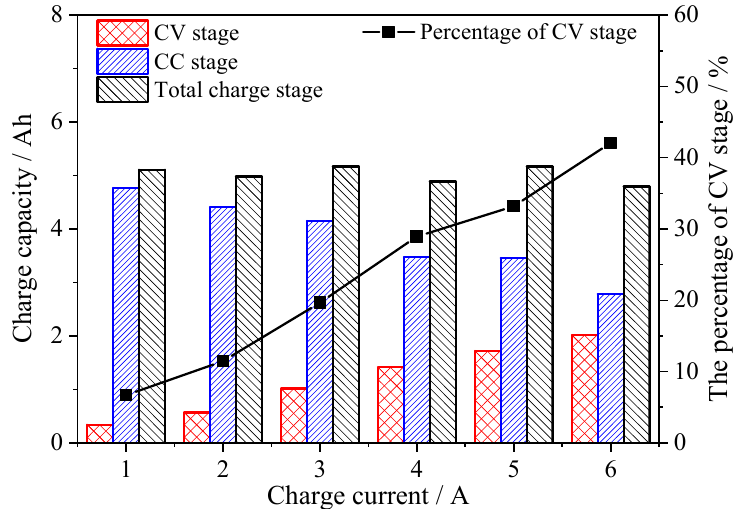
Figure 5. Effect of operating current on charge capacity.